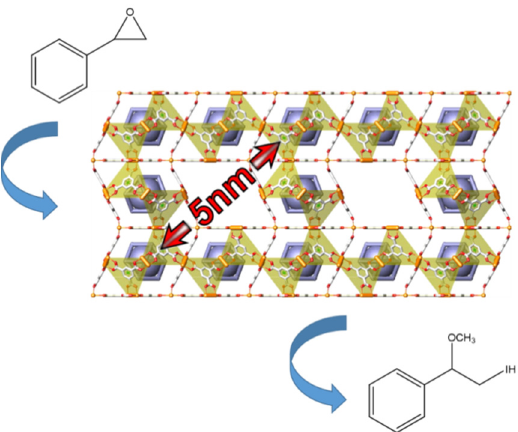
Figure 12. A copper benzene tricarboxylate metal–organic framework, COK-15, with a wide permanent mesoporous feature stabilized by Keggin POM ions for the methanolysis of styrene oxide. Adapted with permission from [121]. Copyright (2012), American Chemistry Society.